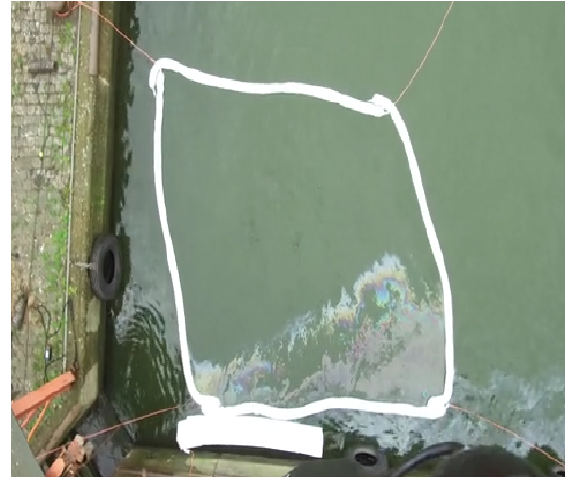
Figure 6. view from drone on test setup inside the